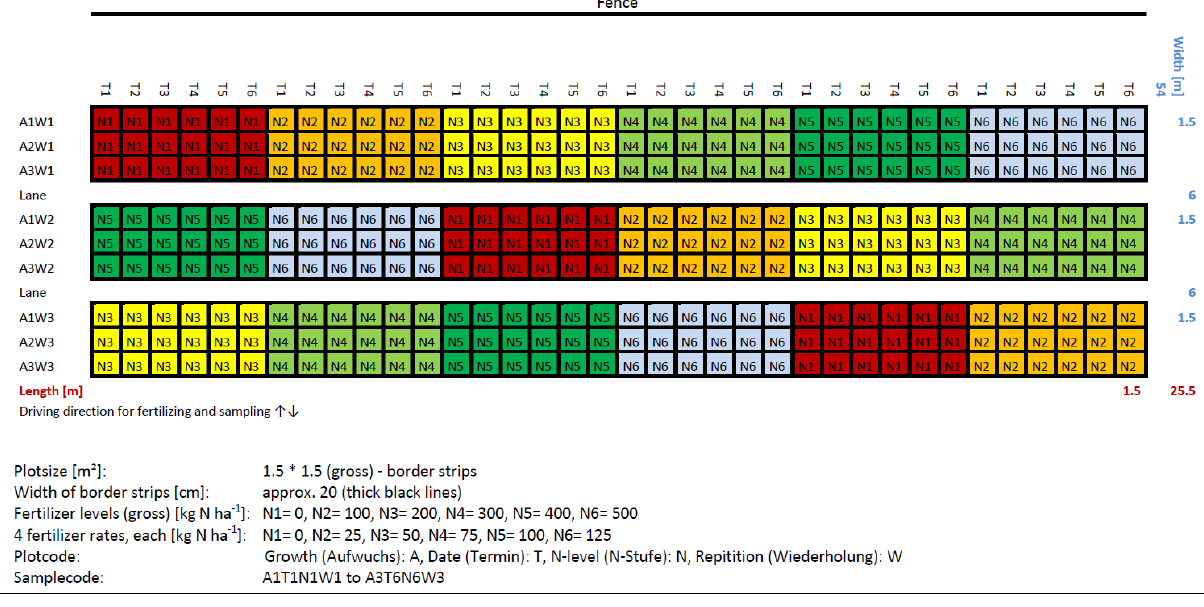
Figure 1. Experiment Plan